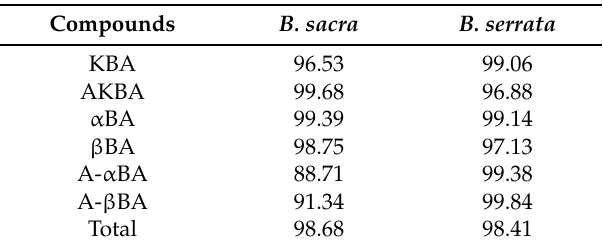
Table 4. Percentage of recovery of identified BAs from B. sacra and B. serrata methanolic extracts. Values are expressed as percentage of